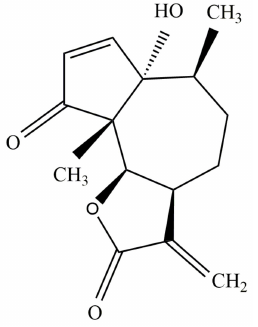
Figure 2. Structure of parthenin.